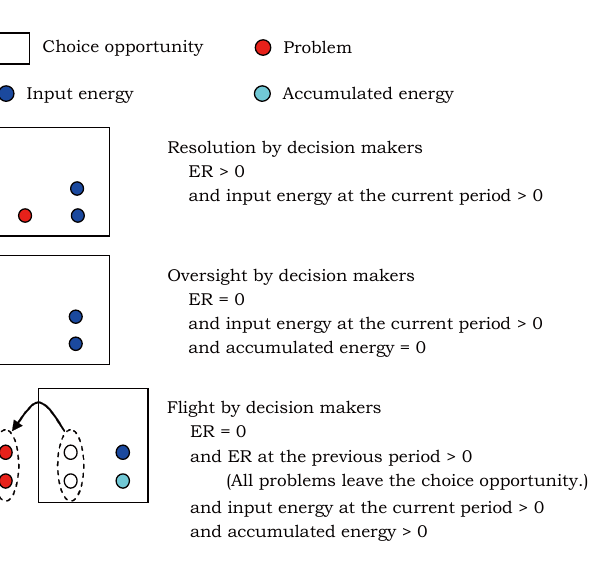
Figure 3. Three decision styles assumed by Cohen et al.